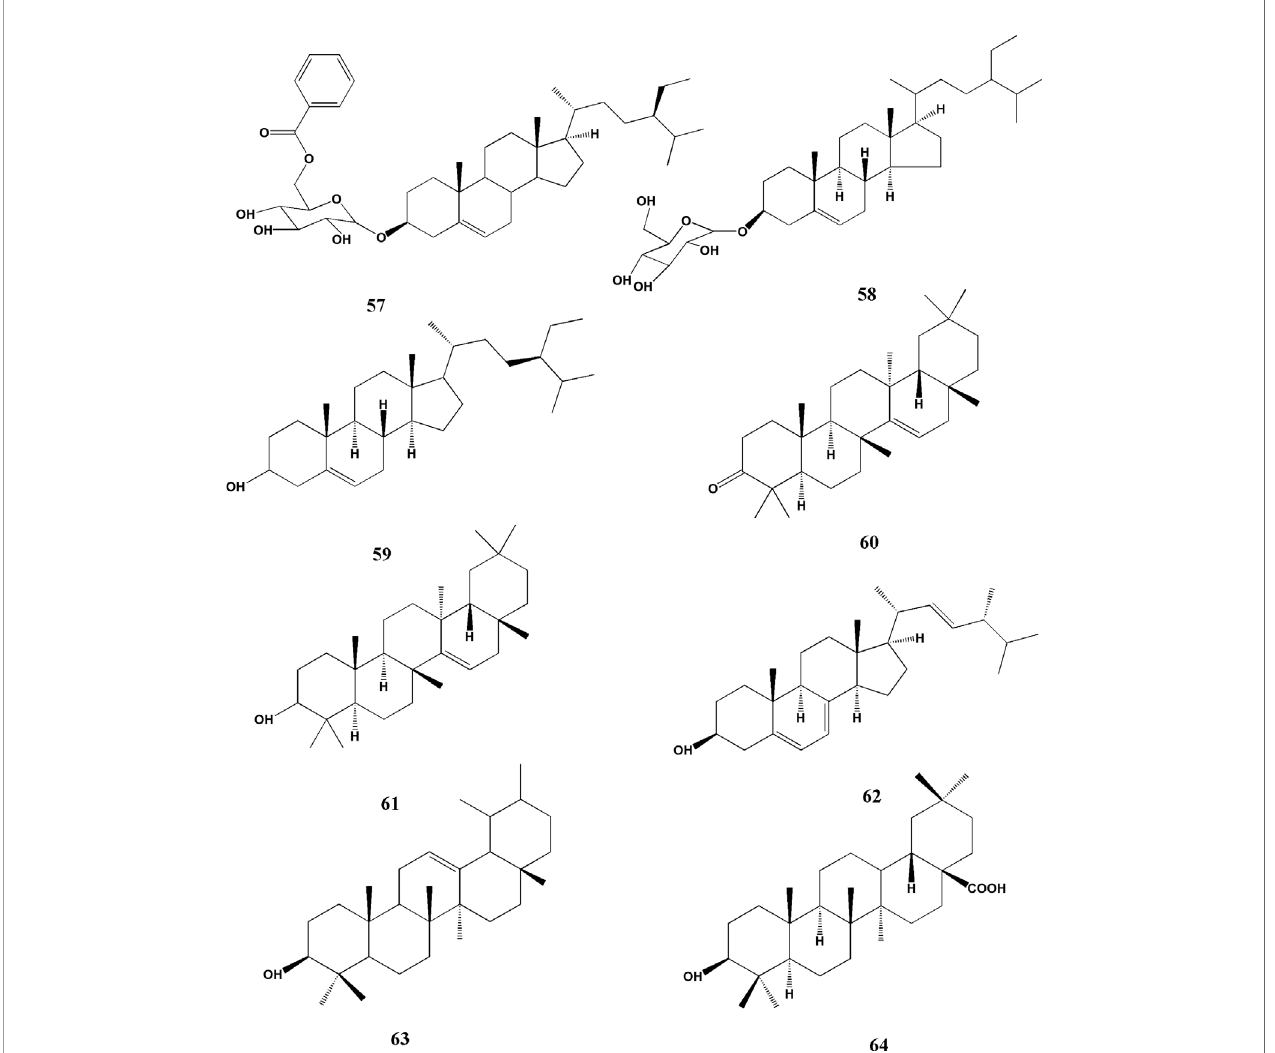
FIGURE 4 | Structures of triterpenoids and steroids from Tetrastigma hemsleyanum Diels &